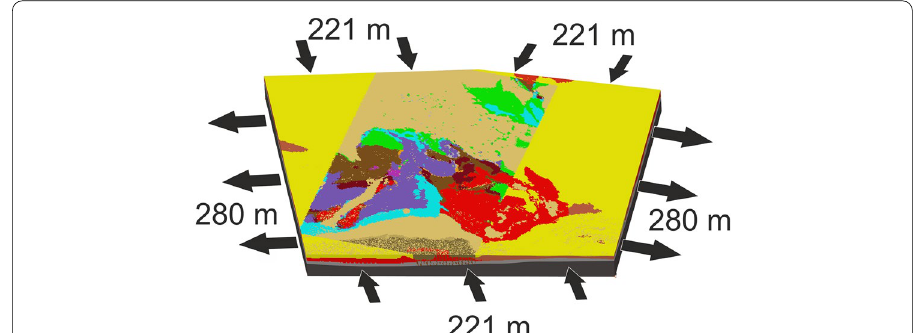
Fig. 4 Displacement boundary conditions applied at the discretized model. Arrows indicate direction of the displacements applied, numbers the magnitudes of displacements defined for the